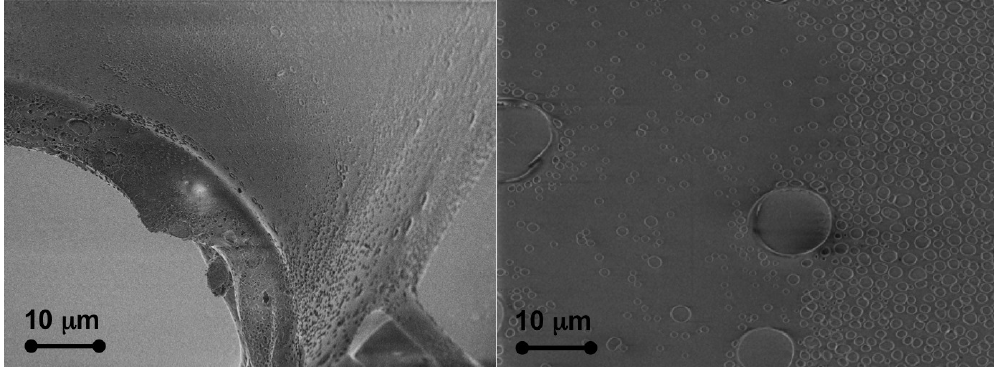
Figure 3. The effect of the ethyl-acetate procedure on the fiber surface. ( Left ) The point where the cladding is removed: the 10 µ m edge is clearly visible; ( Right ) The core surface after the removal procedure: the core appears clean and